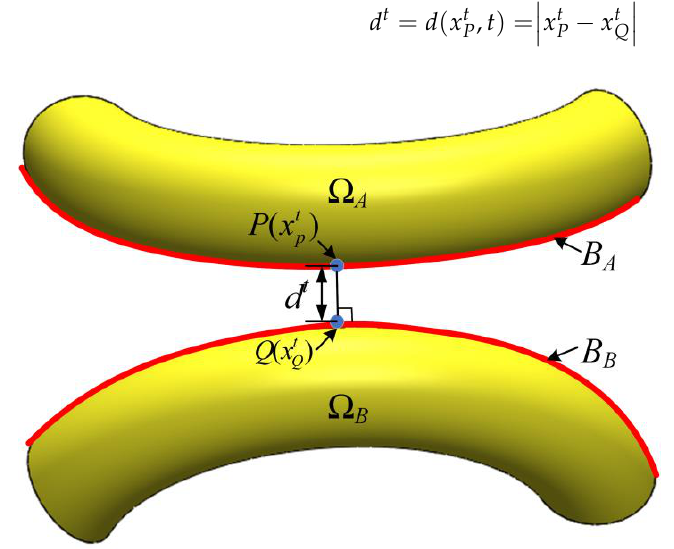
Figure 6. Contact pair between net tethers.